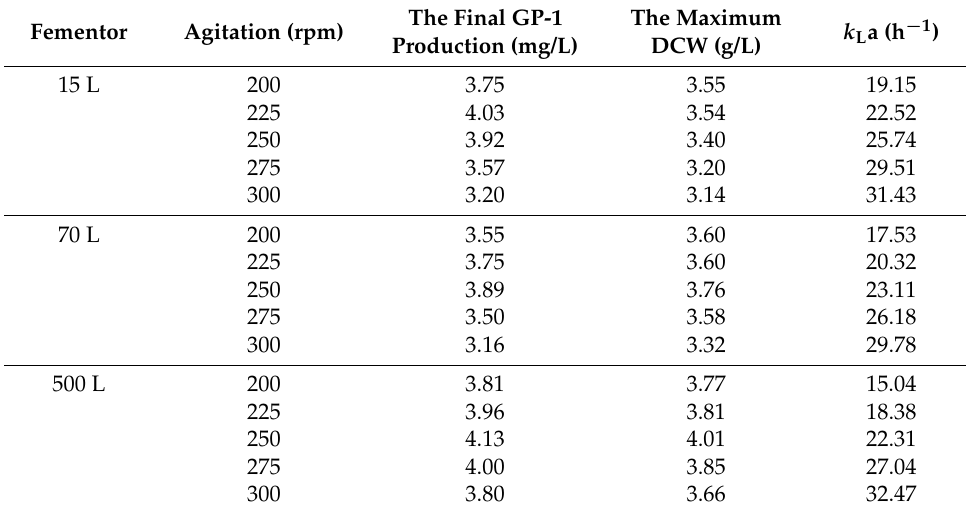
Table 3. Measured k L a values at different fermentation conditions in pilot-scale fermentors. Fementor